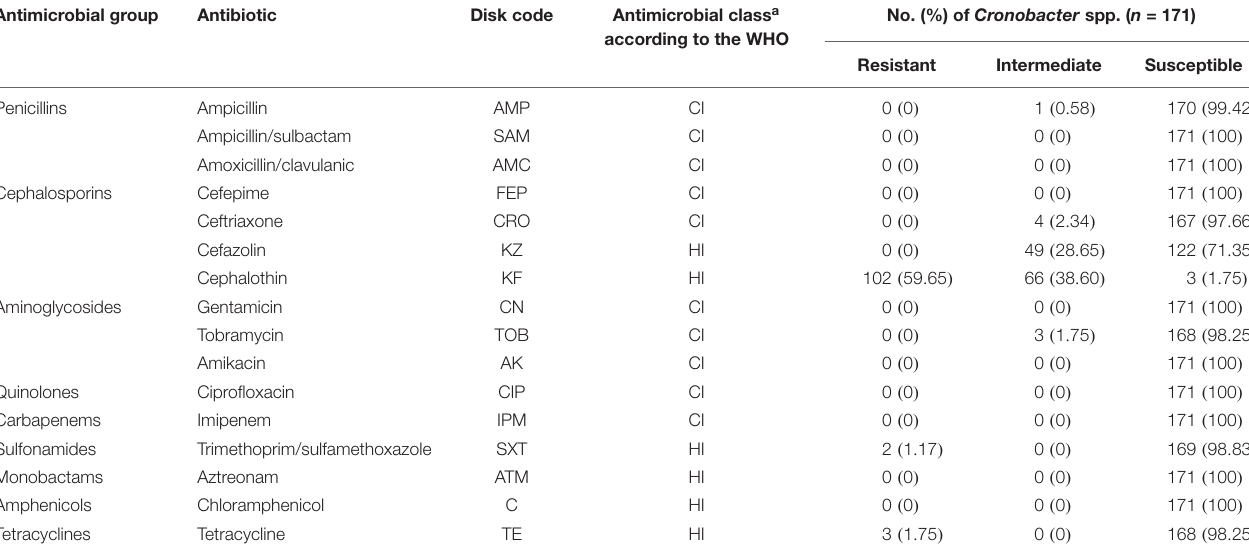
TABLE 5 | Antimicrobial resistance profiles of 171 Cronobacter spp. isolates. Antimicrobial group